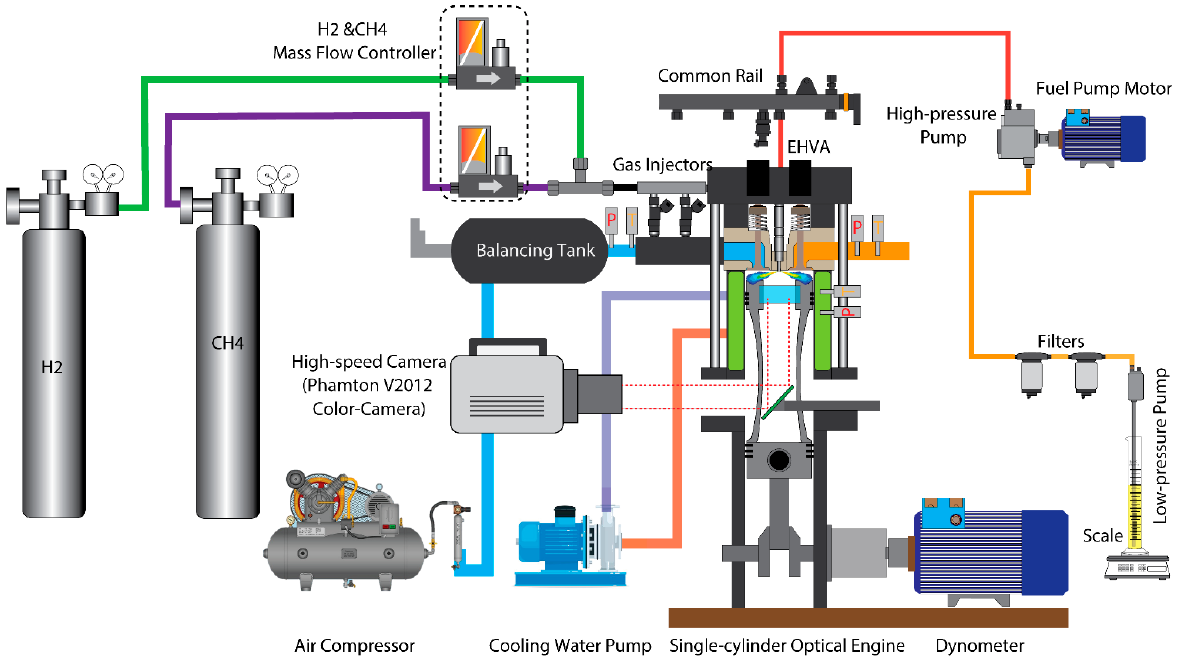
Figure 1. Schematic of the optical engine and high-speed camera location relative to the combustion chamber. (Note: P represents the pressure sensor, and T represents the thermocouple). Table 1. Specifications of optically accessible engine.